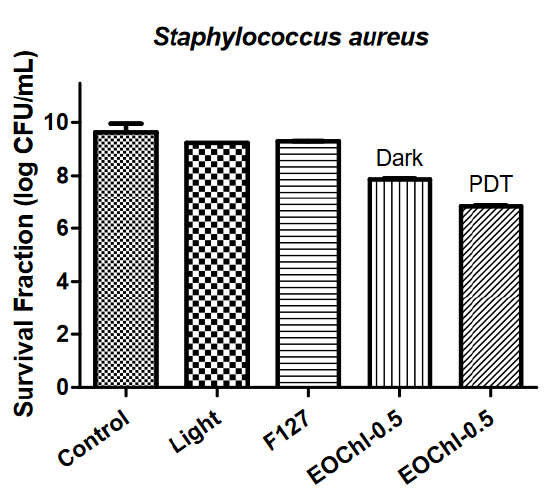
Figure 9. Total S. aureus count expressed in log CFU/mL.